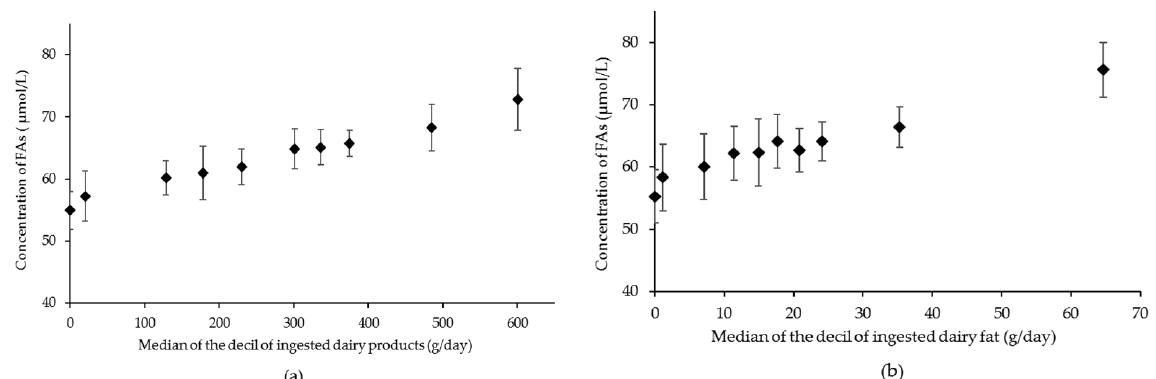
Figure 3. Relation between dairy products ( a ) or dairy fat ( b ) intake, and the sum of the concentrations of iso16:0, iso17:0, cis6 -18:1, trans11 -18:1, and cis9,trans11 -CLA in plasma. Intake data were divided in deciles. The 0 decile includes all data from participants who declared no dairy intake. Fatty acid concentrations are least-squares means of each decile, adjusted for energy intake (Kcal/day). Bars represent ± SD values. Median values of intake for each decile are entered as a continuous variable to obtain the P value for the linear trend. p -values were < 0.001 in both cases. CLA, conjugated linoleic acid.